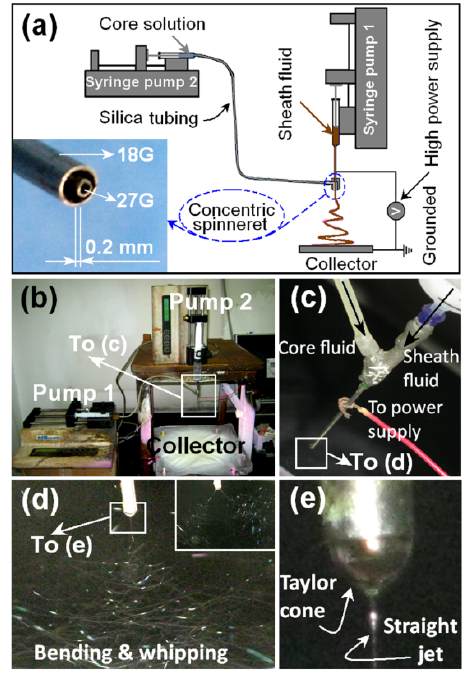
Figure 1. Coaxial electrospinning: ( a ) Schematic diagram of the process; the inset shows the nozzle of the homemade concentric spinneret; ( b ) Digital image showing the apparatus arrangement; ( c ) Connection between the power supply and the spinneret; ( d ) A typical fluid jet trajectory; the inset division of fluid jets is a result of a higher applied voltage of 16 kV; ( e ) A typical compound Taylor cone of the core/sheath fluids. Under a voltage of 14 kV and a collected distance of 20 cm with the flow rate of the sheath and core fluids are 1 and 0.7 mL/h, respectively, for the preparation of nanofibre